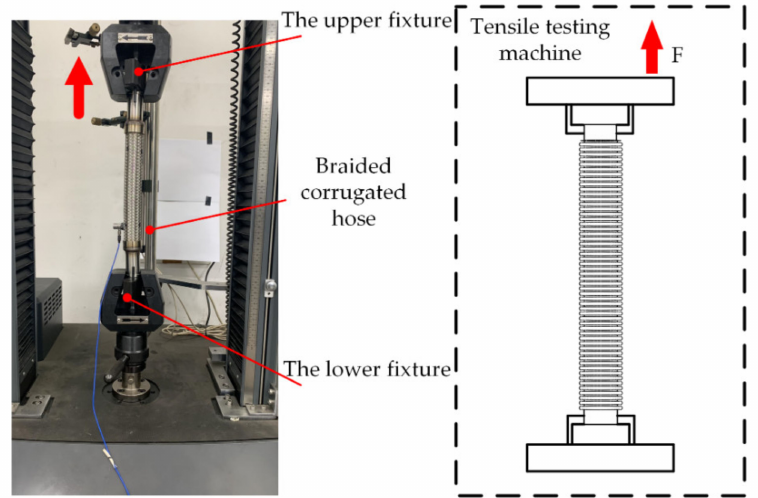
Figure 14. Tensile testing apparatus.